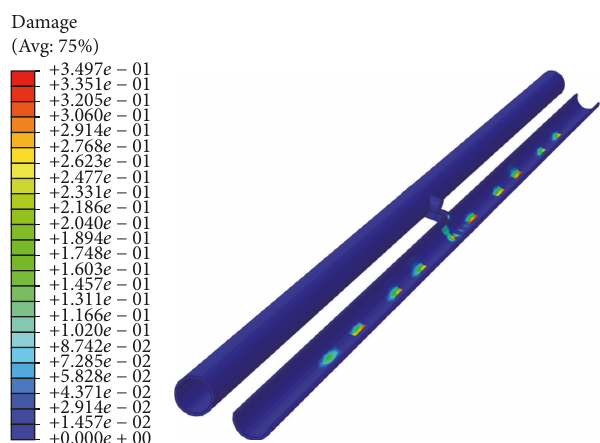
Figure 13: Distribution nephogram of cumulative tensile damage of cross structure (102.74 a).